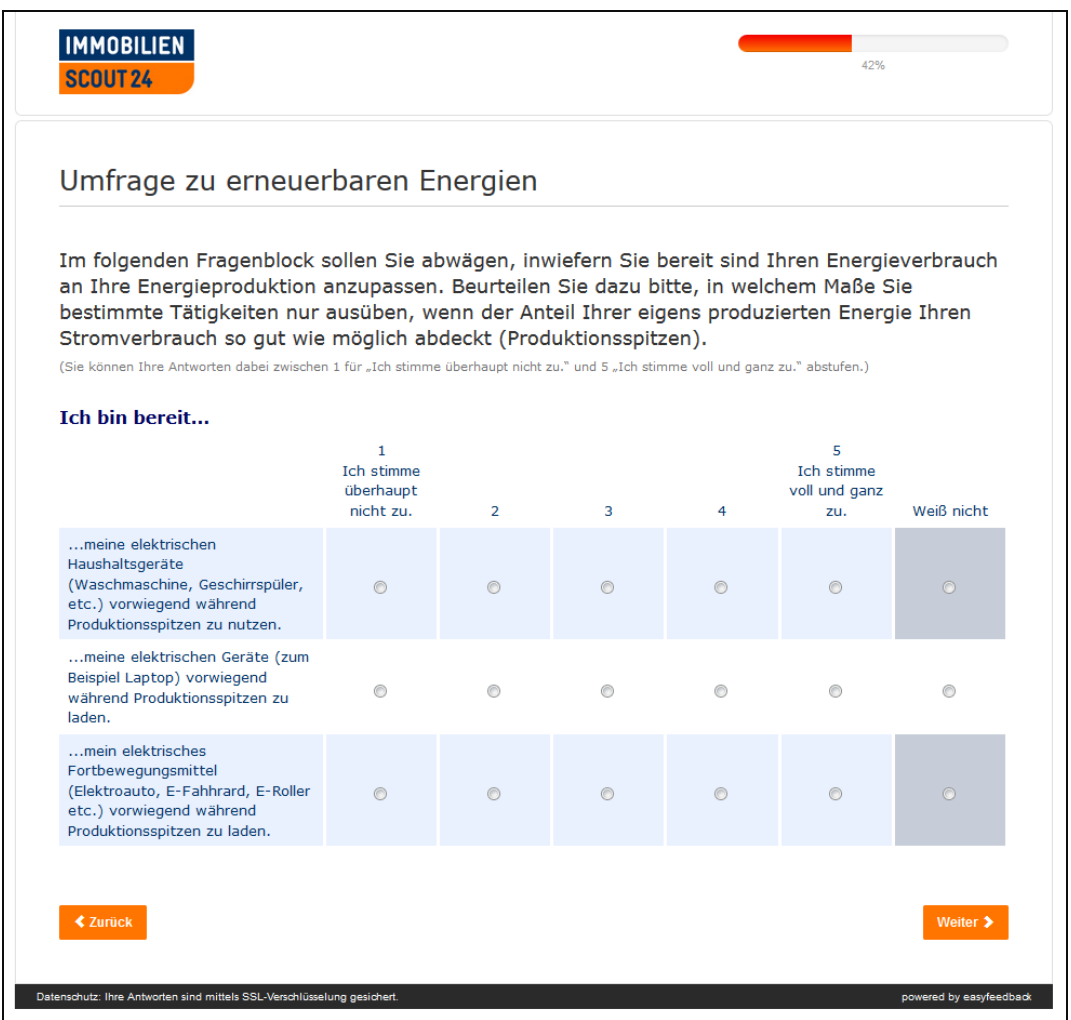
Figure A9. Screenshot of Questionnaire Page 8.